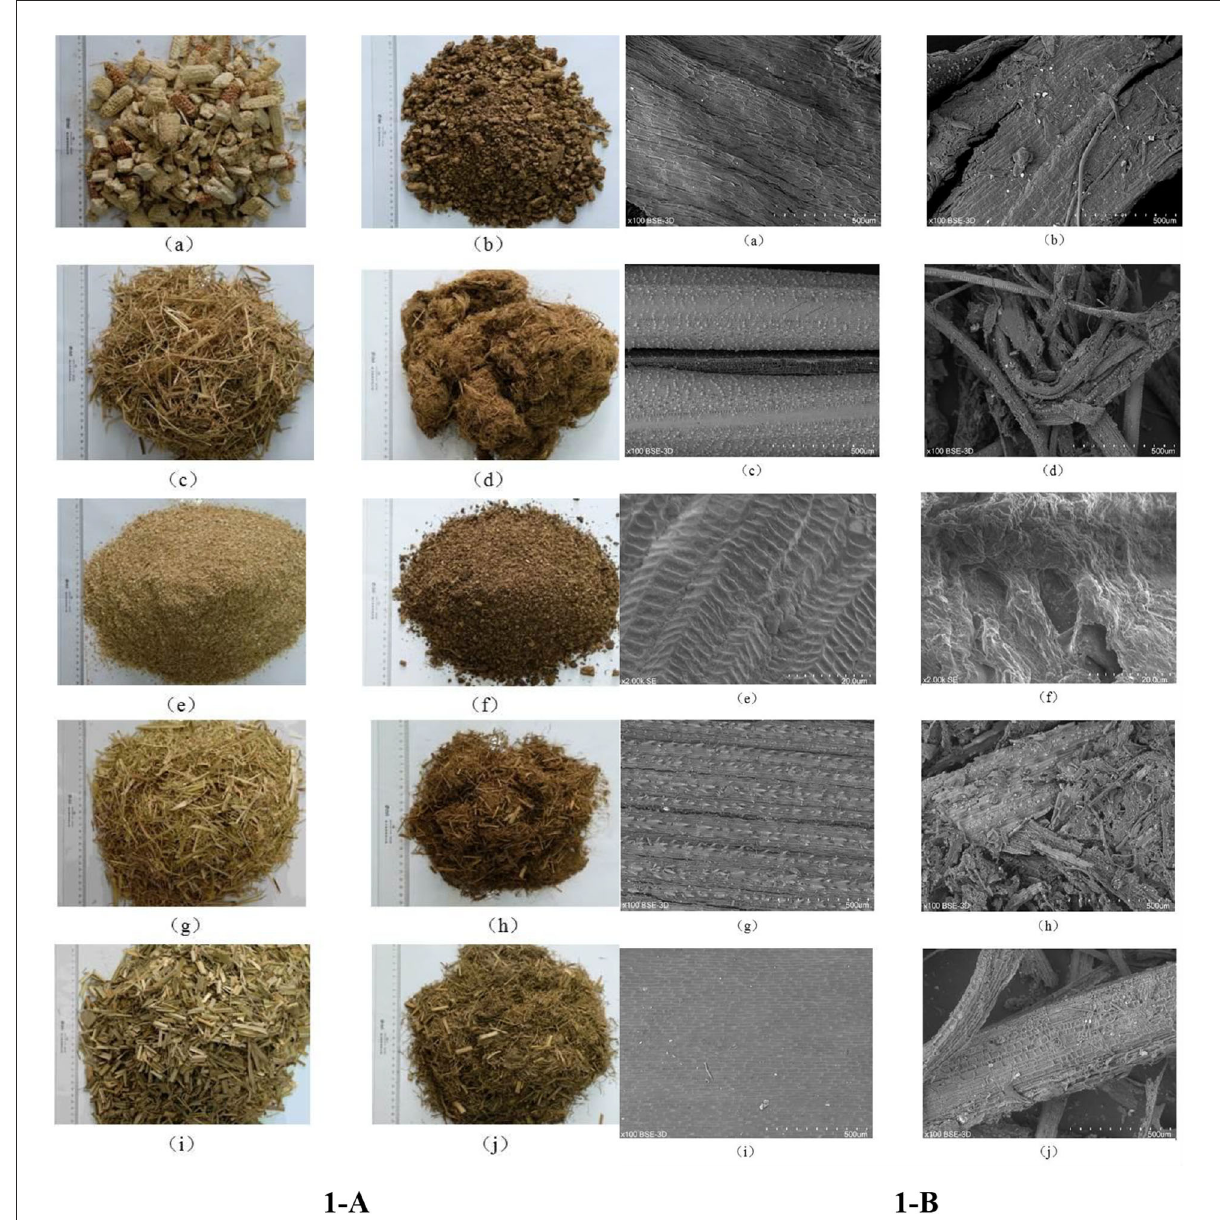
FIGURE1 Physical appearance (A) and scanning electronic microscope observation (B) of feedstuffs before and after steam explosion processing (a: raw corn cob; b: steam-exploded corn cob; c: raw rice straw; d: steam-exploded rice straw; e: raw peanut shell; f: steamed-exploded peanut shell; g: raw millet stalk; h: steamed-exploded millet stalk; i: raw sugarcane tip; j: steam-exploded sugarcane